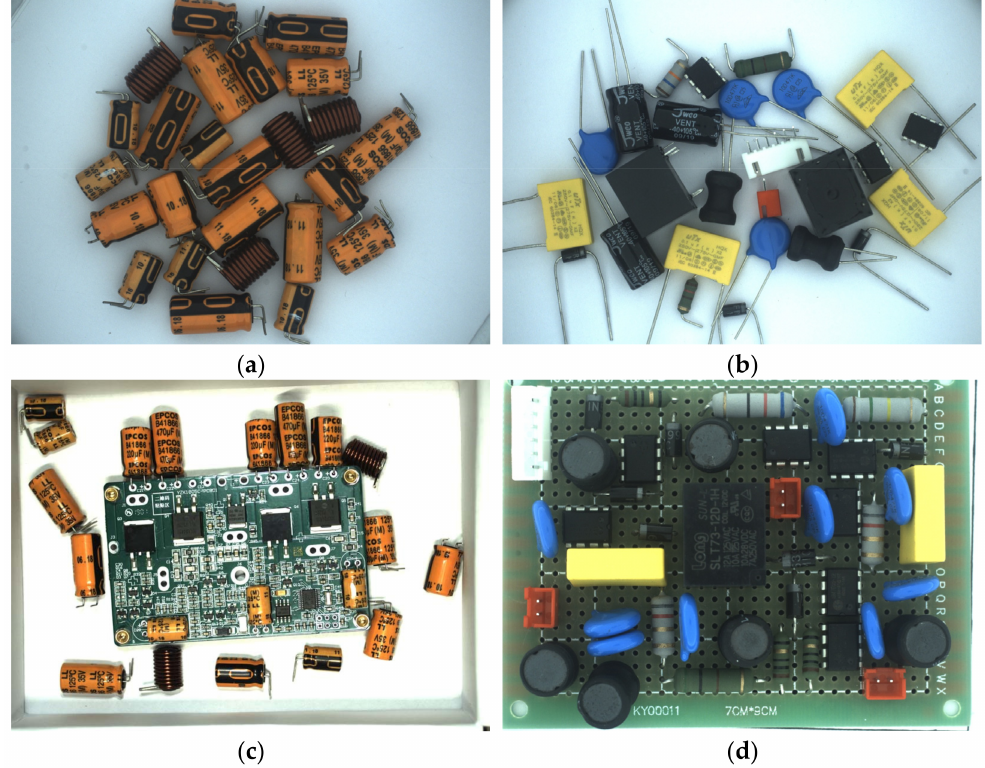
Figure 1. Different scenes in a multi-scene electronic component dataset: ( a , b ) pre-assembly scene; ( c ) in-assembly scene; ( d ) post-assembly